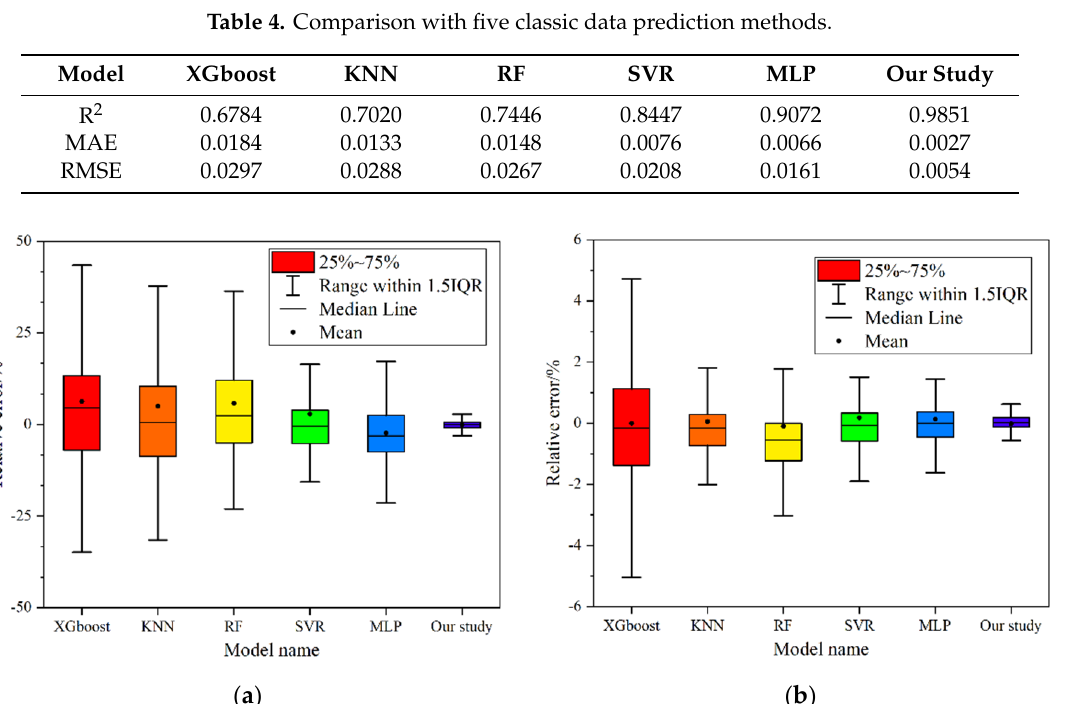
Figure 15. Prediction results under different methods: ( a ) power; ( b ) efficiency.